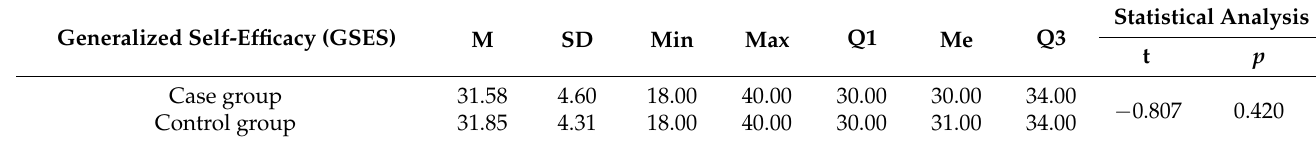
Table 4. The comparative analysis of the generalized self-efficacy between the study group and the control group.